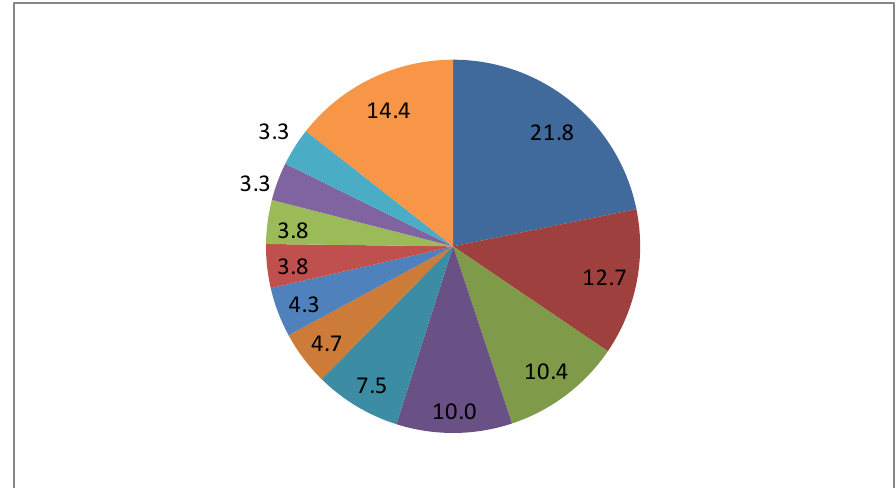
Fig.1. Topics of scientific researches of students’ physical culture and sports problems, %: 1–Health and life quality, 21.8%; 2–Physical education, 12.7%; 3–Sport games, 10.4%; 4–Martial arts, 10.0%; 5– Acrobatic, gymnastic, kinds of aerobics, 7.5%; 6–Power kinds of sports, 4.7%; 7–Biomechanics, 4.3%; 8–Psychological problems, 3.8%; 9–Water and winter kinds of sports, 3.8%; 10–Cadets’ training, 3.3%; 11–Teachers’ training, 3.3%; 12–The rest,